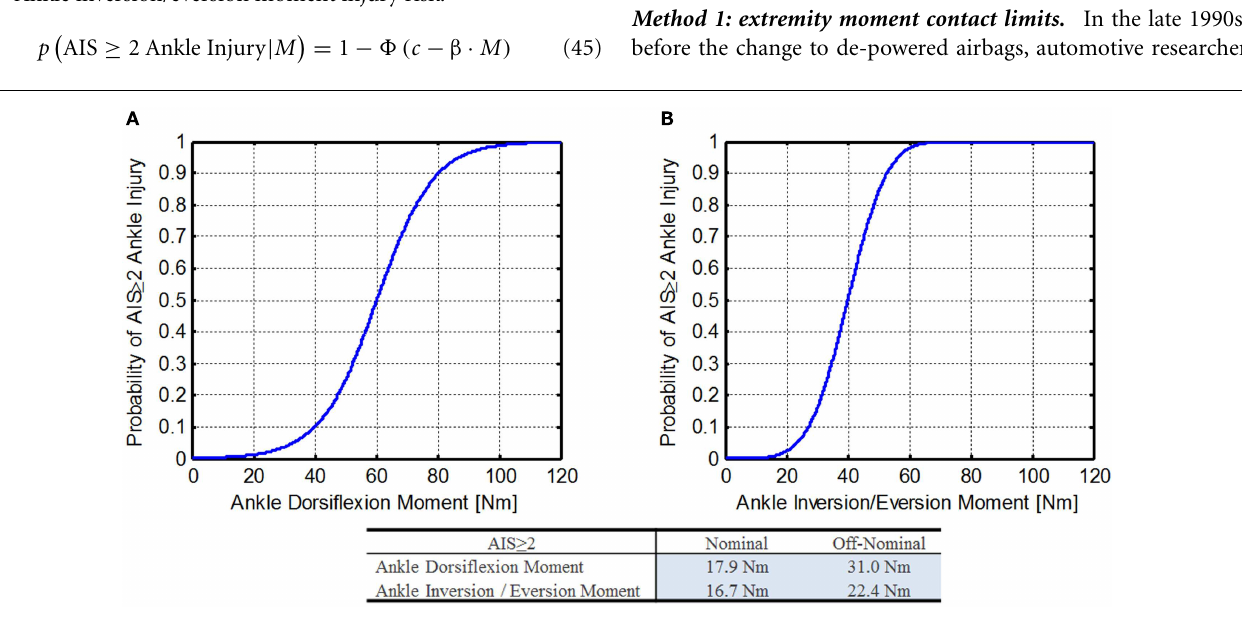
FIGURE 10 |Ankle moment injury risk functions (Kuppa et al., 2001) . (A) Dorsiflexion ankle moment and (B) inversion/eversion ankle